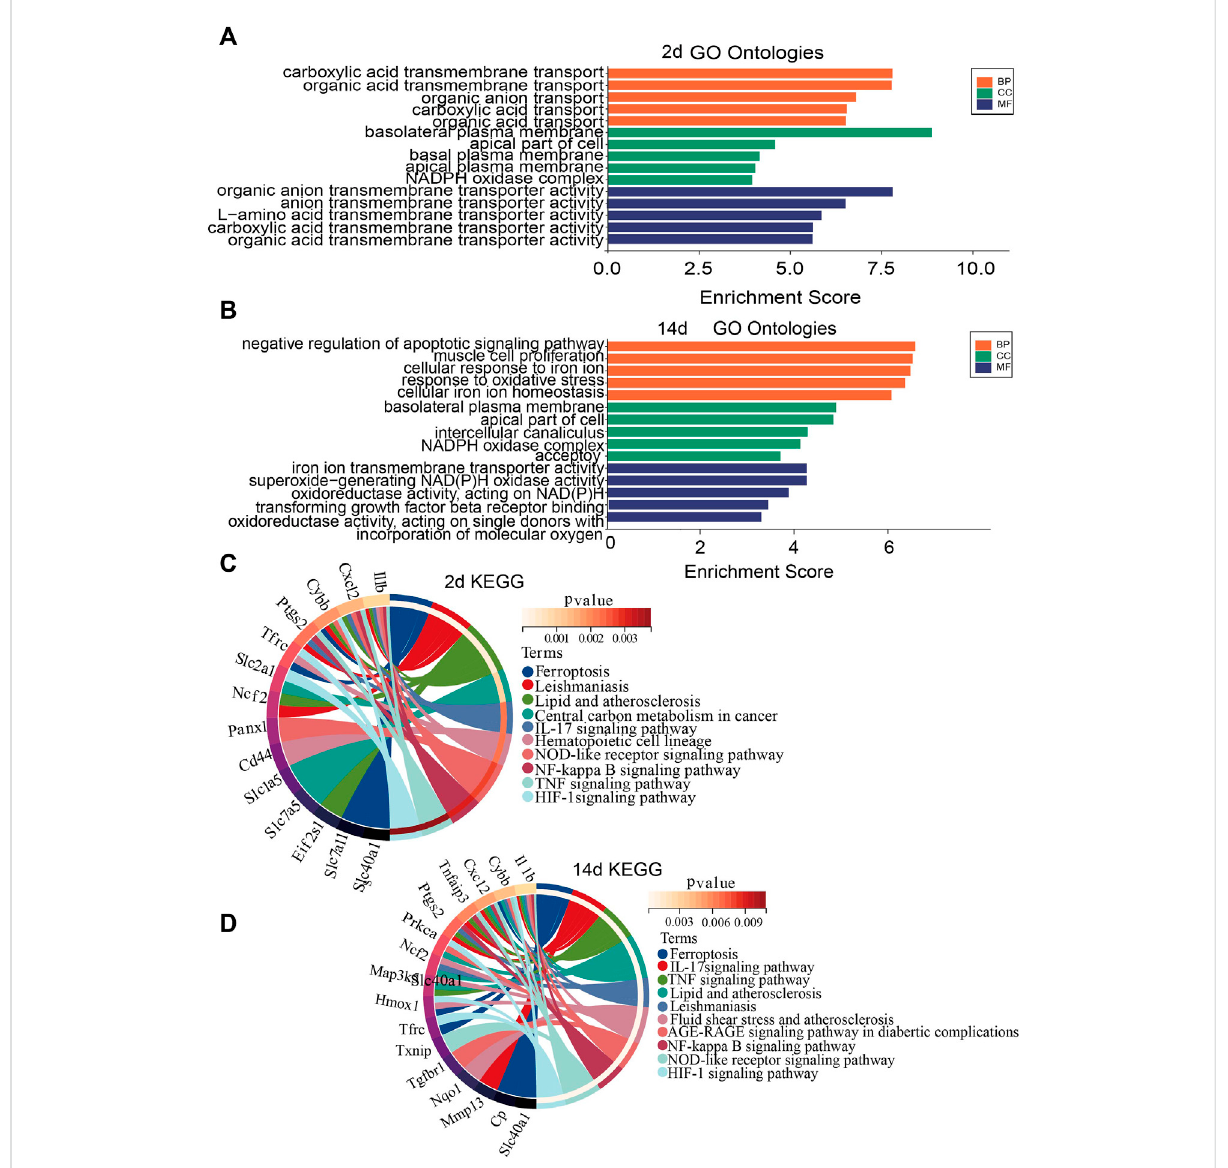
FIGURE 3 GeneOntology(GO) andKyotoEncyclopediaofGenesandGenomes(KEGG)enrichmentanalysis ofFRGs. (A) GOenrichmentanalysisofFRGs 2days after ligation. (B) GO enrichmentanalysisofFRGs14 days after ligation. (C) Relationship amongthe top10 enriched KEGG pathway termsand targets is represented in a chord plot 2 days after ligation. (D) Relationship among the top 10 enriched KEGG pathway terms and targets is represented in a chord plot 14 days after ligation. BP, biological processes; CC, cellular component. MF, molecular